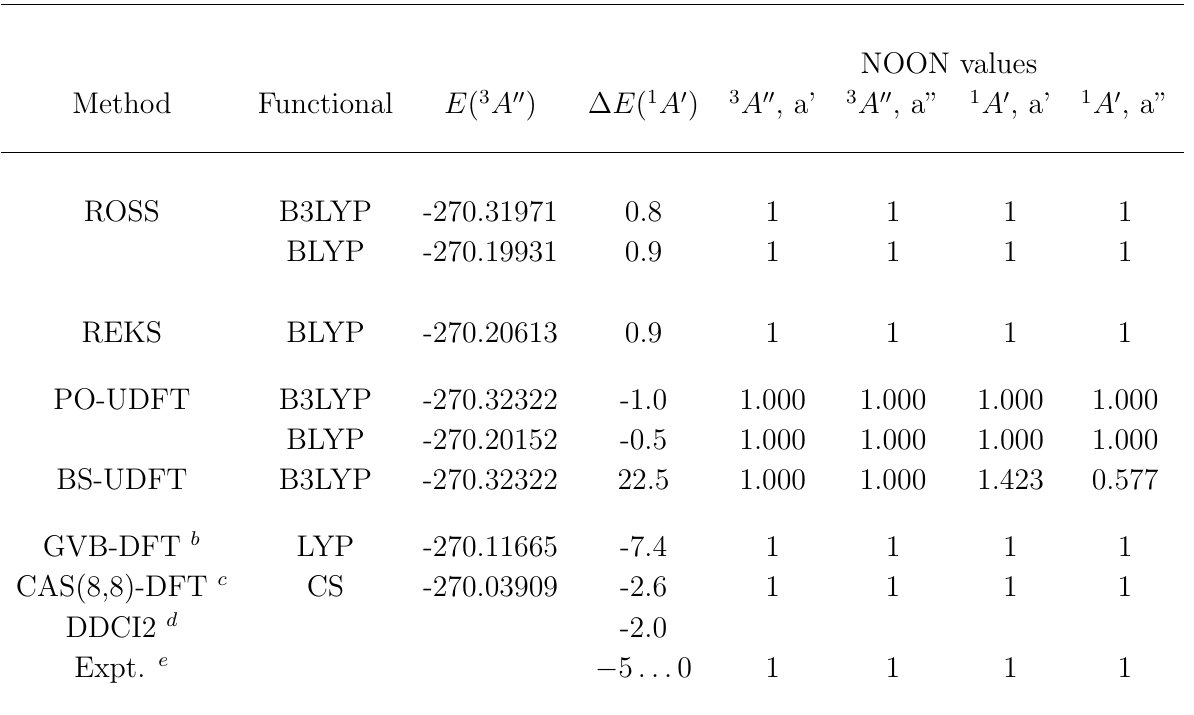
Table 2. Singlet and triplet energies for α -3-didehydrotoluene ( 2 ). a )